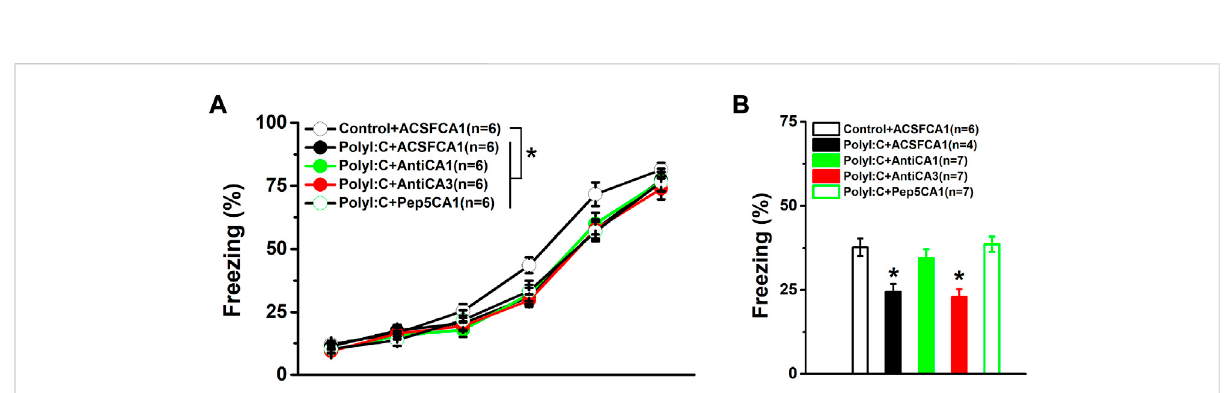
The performance in the conditioning and fear memory test. PolyI:C-treated offspring were intra -CA1 or -CA3 infused with anti-proBDNF antibody or p75 NTR inhibitor TAT-Pep5 30 min before the testing. The freezing levels of polyI:C-treated offspring during the training (A) and the memory test (B) are lower while blocking the activation of proBDNF/p75 NTR signaling can effectively reversed the impaired memory behavior. Data are presented as mean ± SEM. * p < 0.05, Control + ACSFCA1 vs. other groups in A and the group vs. Control + ACSFCA1, PolyI:C + AntiCA1 and PolyI:C + Pep5CA1 in B. Training phase: Control + ACSFCA1: n = 6; PolyI:C + ACSFCA1: n = 6; PolyI:C + AntiCA1: n = 6; PolyI:C + AntiCA3: n = 6; PolyI:C+Pep5CA1: n =6.Memorytest:Control+ACSFCA1: n =6;PolyI:C+ACSFCA1: n =4;PolyI:C+AntiCA1: n =7;PolyI:C+AntiCA3: n =7;PolyI: C + Pep5CA1: n =